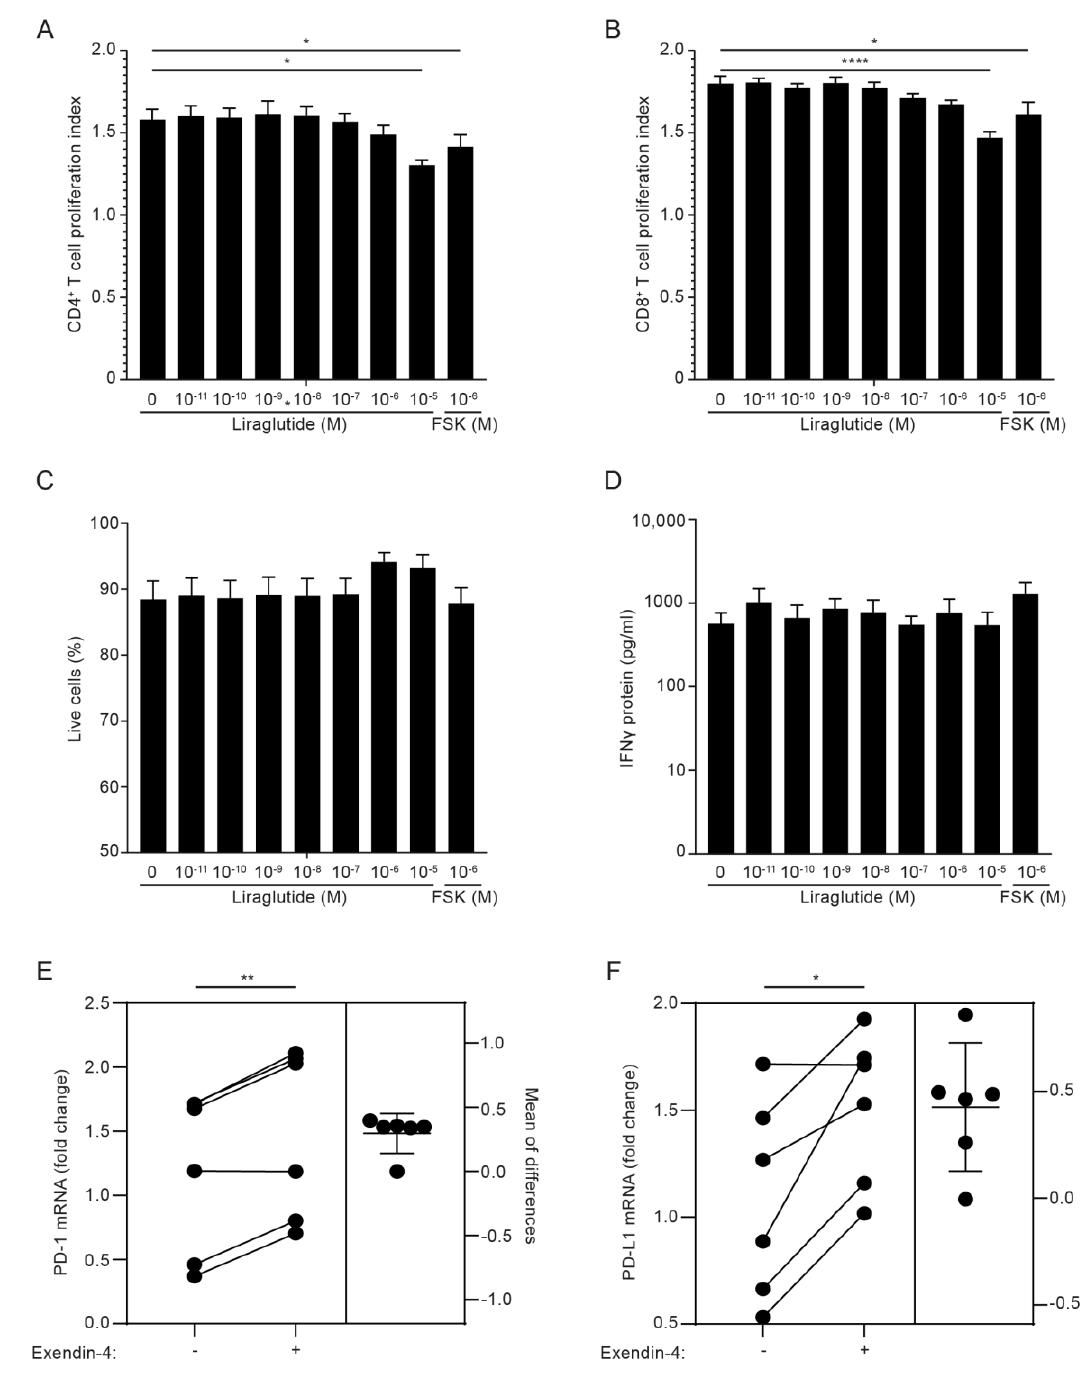
Figure 5. GLP-1RA inhibit proliferation of CD4 + and CD8 + T cells and increase PD-1 and PD-L1 expression in iTreg cells. ( A – D ) Proliferation indexes of CD4 + ( A ) and CD8 + ( B ) T cells, live cell frequency ( C ) and IFNγ production ( D ) from PBMC cultures stimulated with anti-CD3 mAb for 120 h in the presence of the indicated concentration of the GLP-1RA liraglutide (Lira) or forskolin (FSK) (mean + SEM, n = 6, one-way ANOVA with post-hoc test (Dunnett’s), * p < 0.05, **** p < 0.00005. The mean of each column was compared with the mean of the first column). ( E , F ) PD-1 ( E ) and PD-L1 ( F ) expression in CD4 + T cells activated for 120 h in Treg polarizing medium and subsequently not treated or treated with exendin-4 (10 nM) for 24 h, as indicated (estimation plot, n = 6, Student’s t -test, (paired, two-tailed), * p < 0.05, ** p <